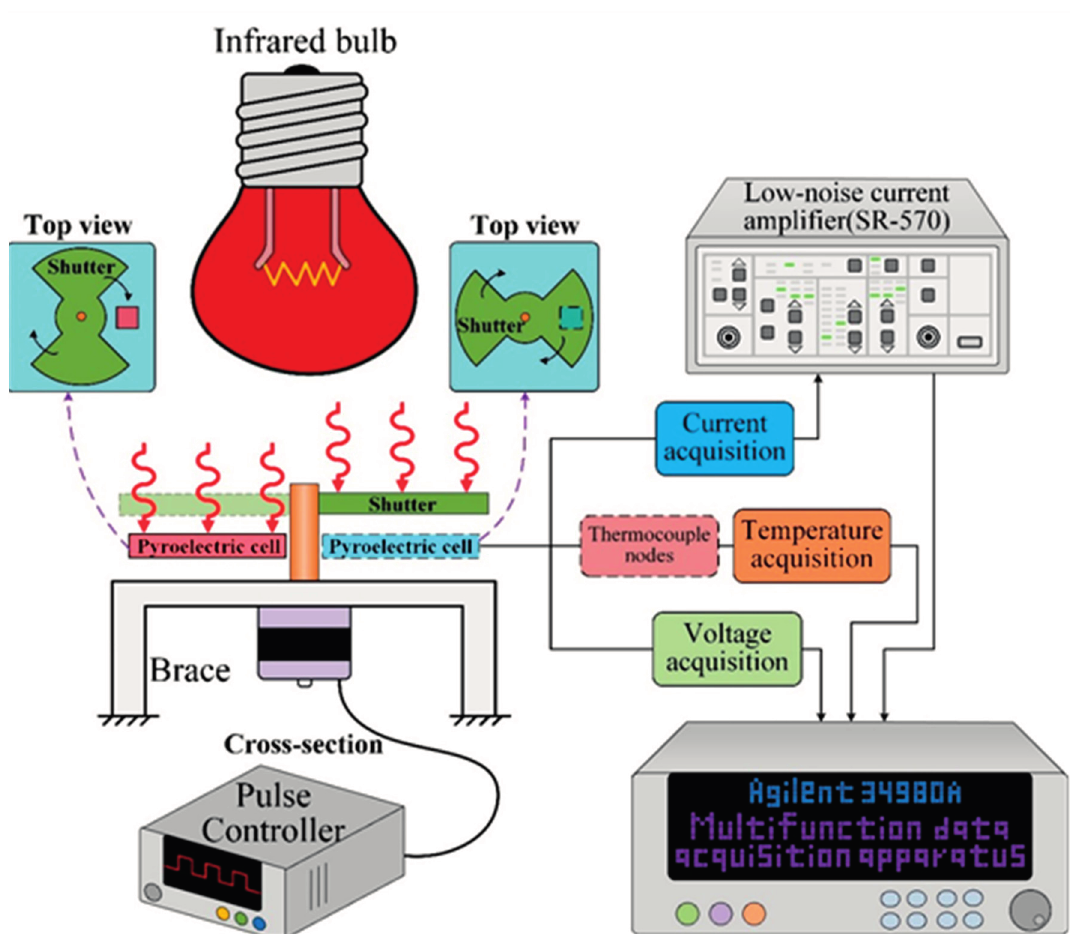
Figure 6. Measurement setup for the pyroelectric